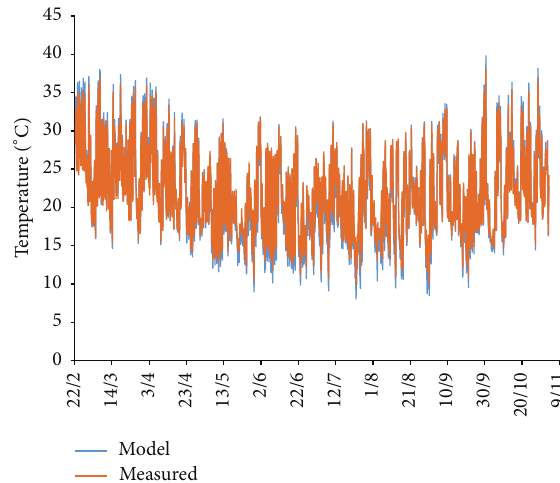
Figure 10: Comparison of the measured and the modeled tempera-